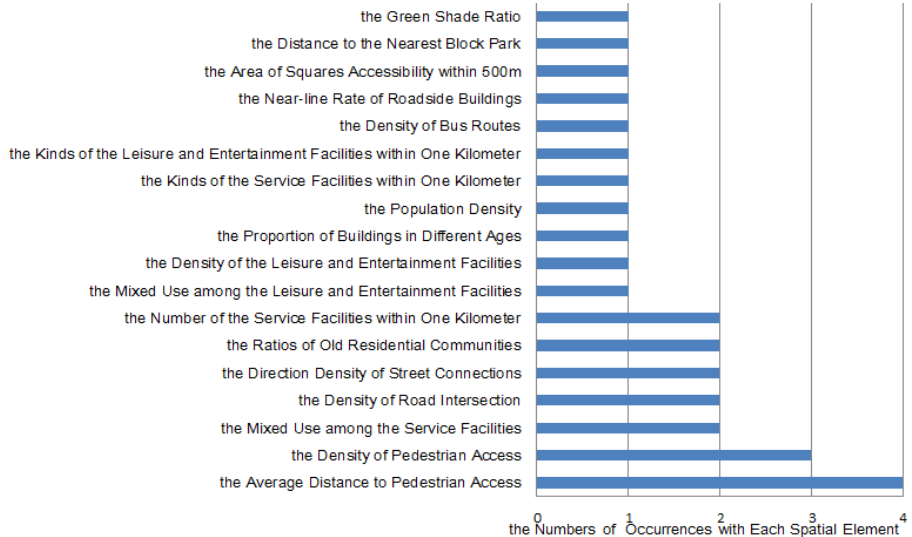
Figure 7. The impact of each spatial element on walking trips.